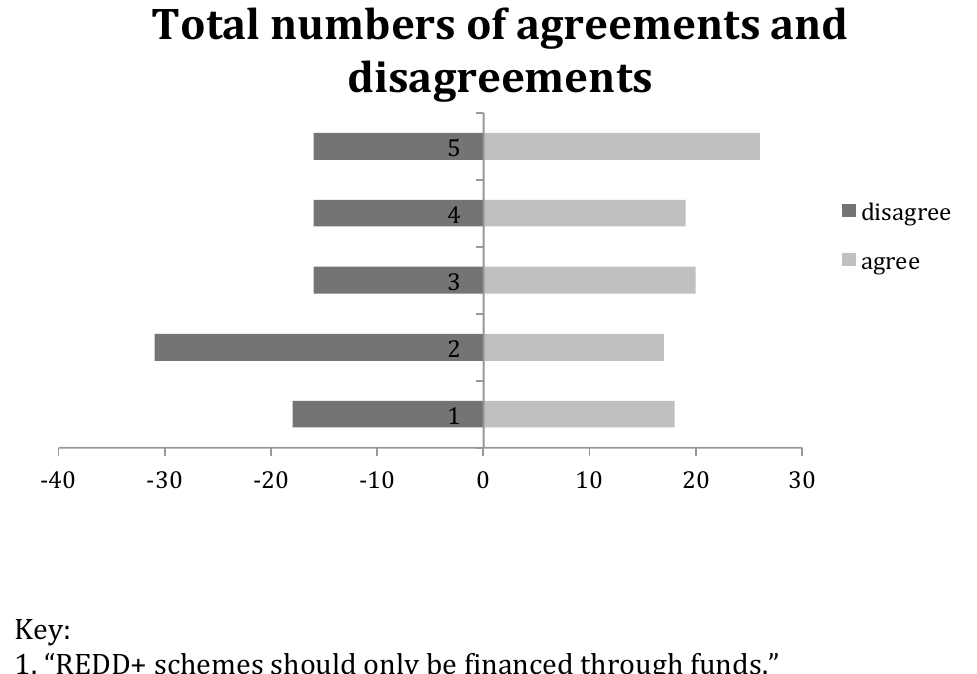
Appendix 1 : Figure A1. Numbers of organizational actors agreeing and disagreeing with the five most divisive stances according to the structured survey